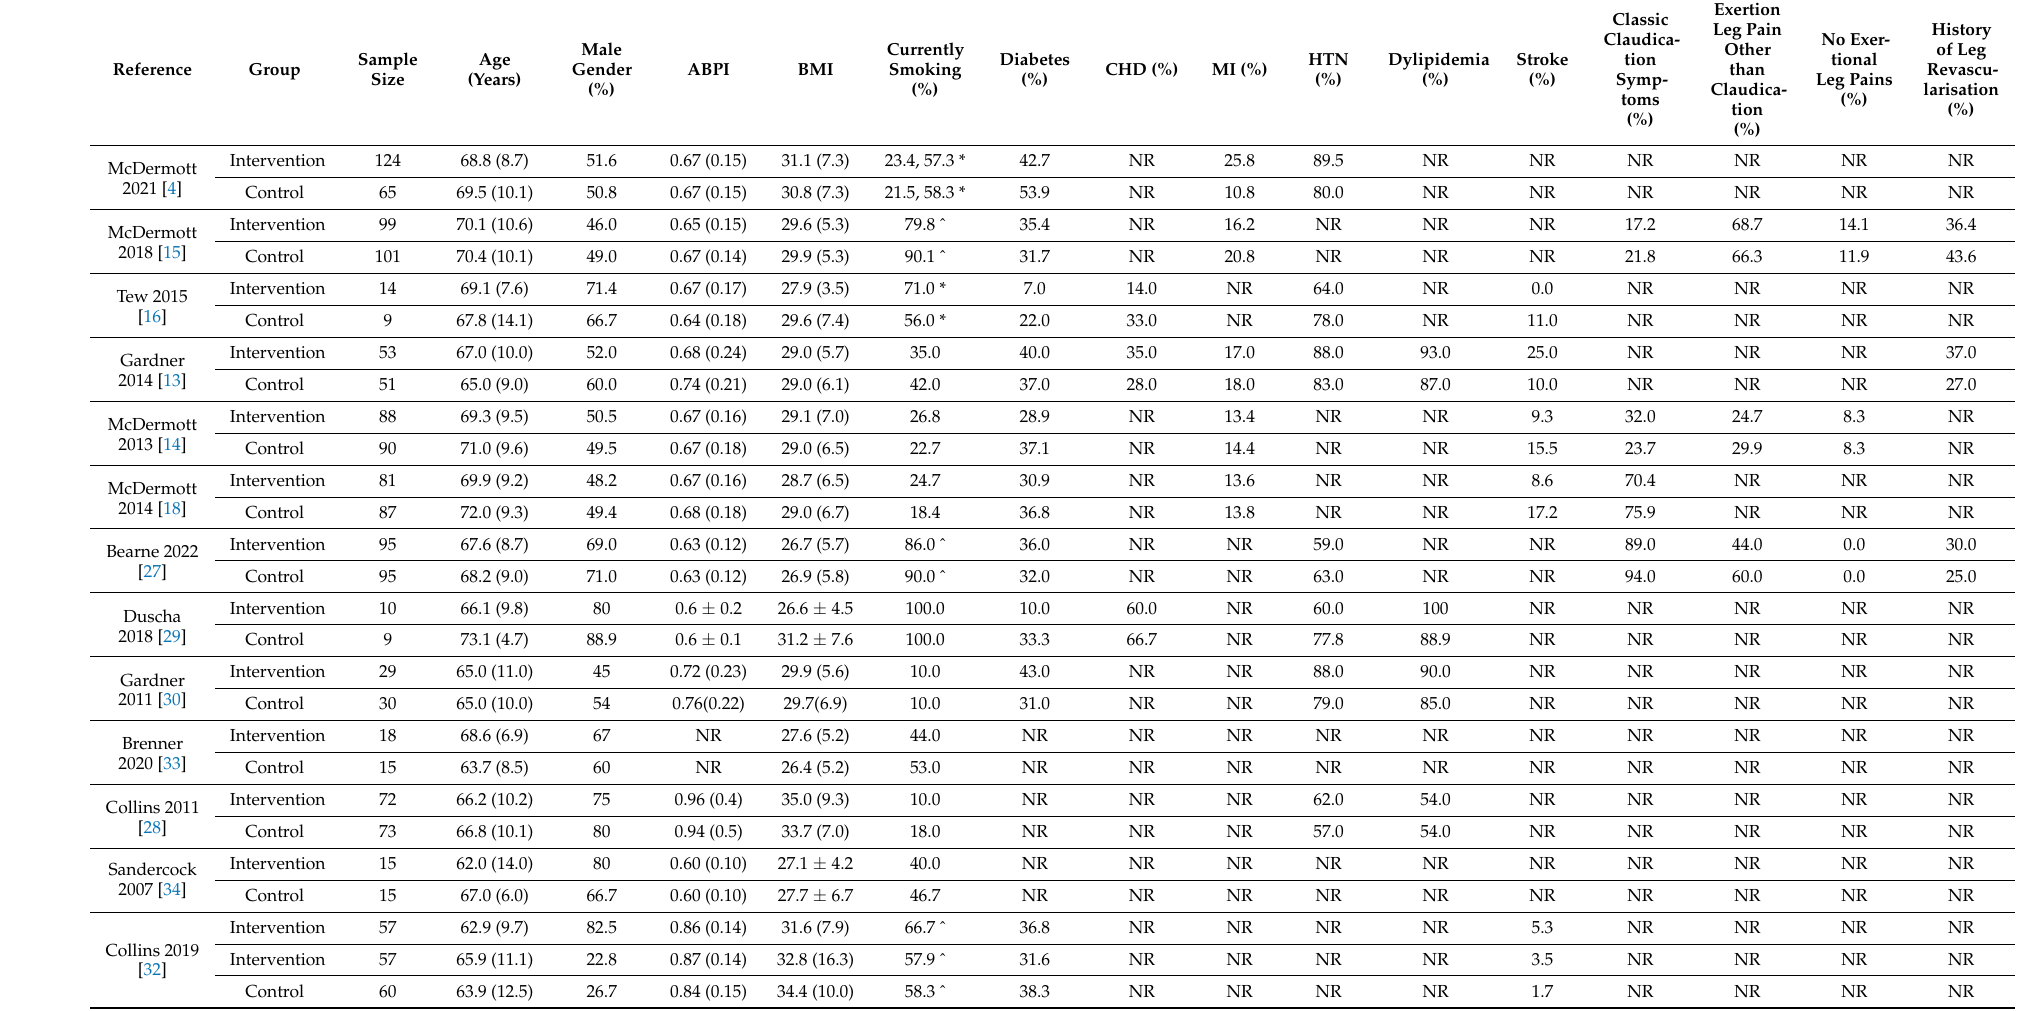
Table 1. Baseline characteristics of participants in the included